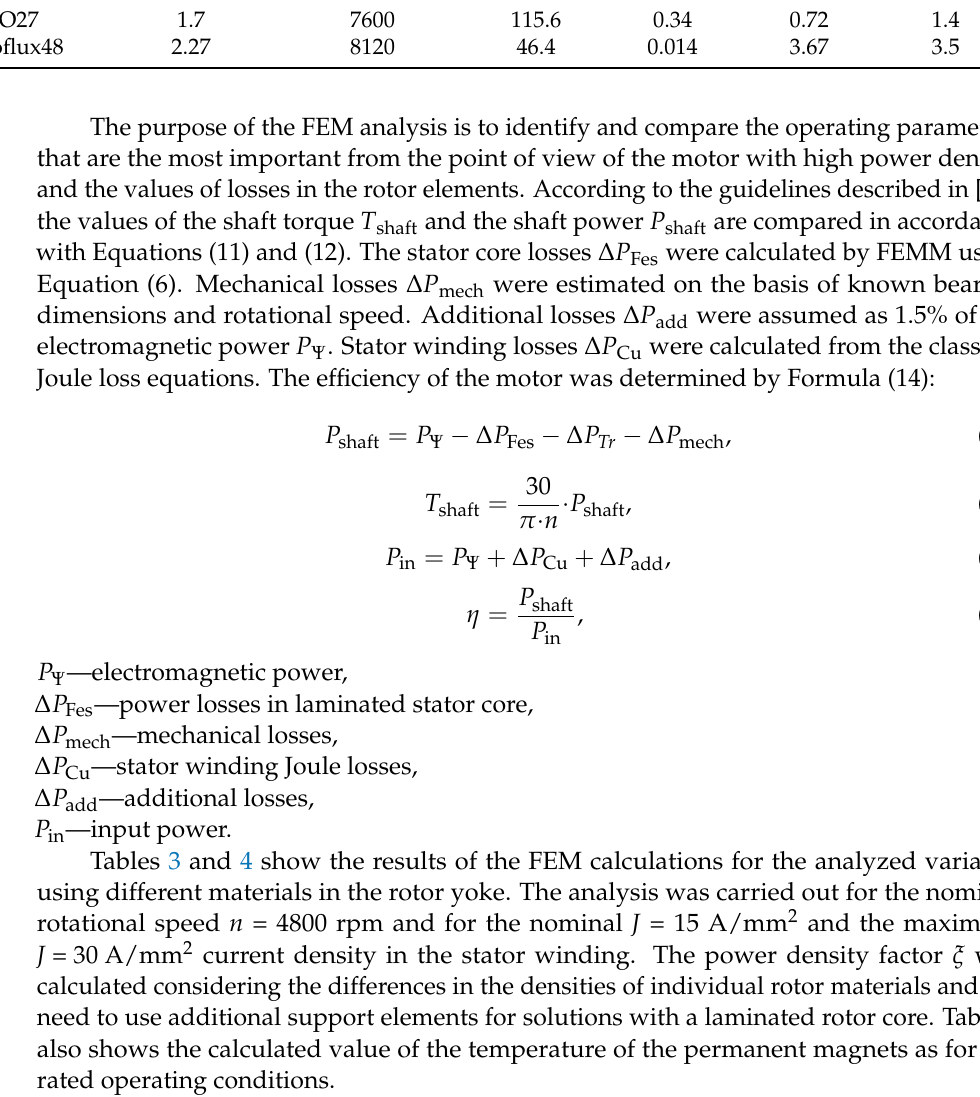
Figure 3. Distribution of the flux density from permanent magnets in the elements of the electro- magnetic circuit of the motor model.